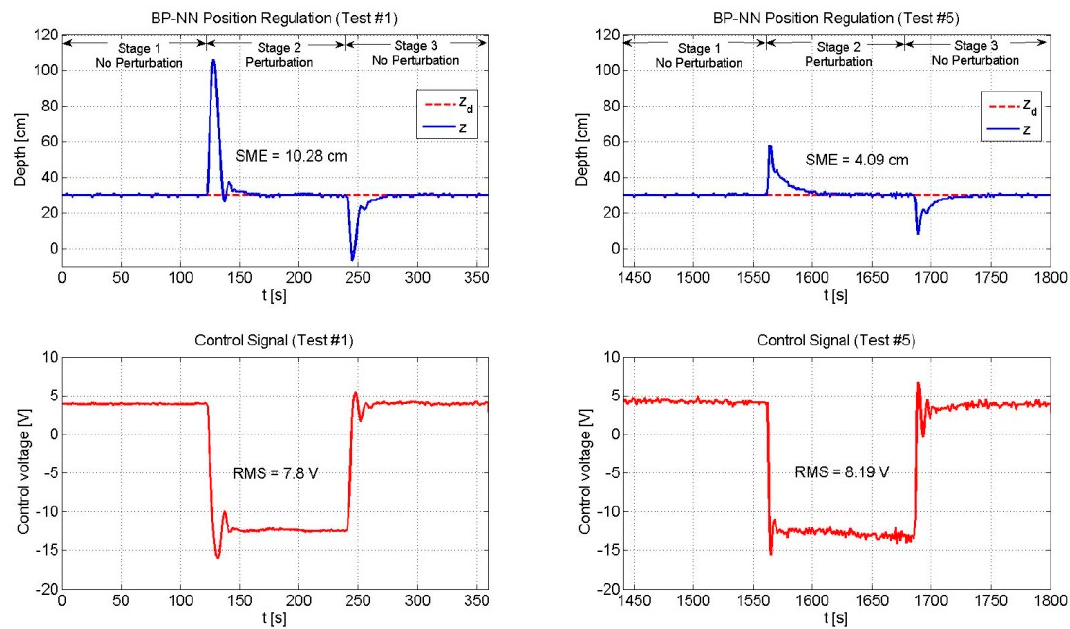
Figure 9. Performance of the BP-NN control. As time went by the neural network updated its weights online in order to drive the position error to zero. In the same fashion, the energy required to achieve a smaller SME increased.